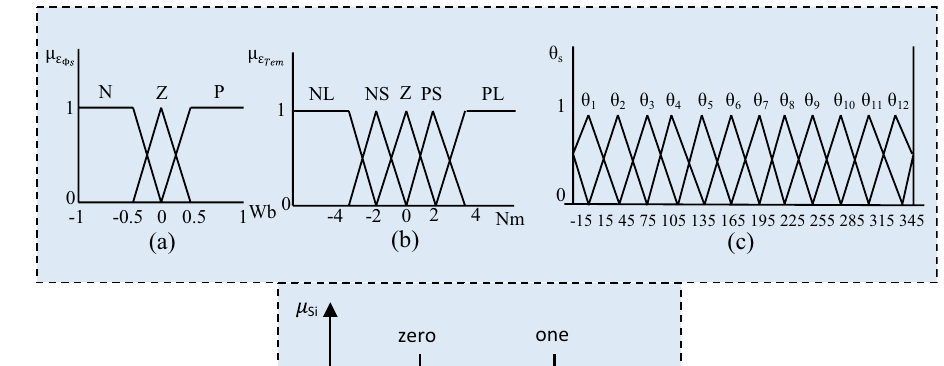
Fig. 9 Membership functions of input and output